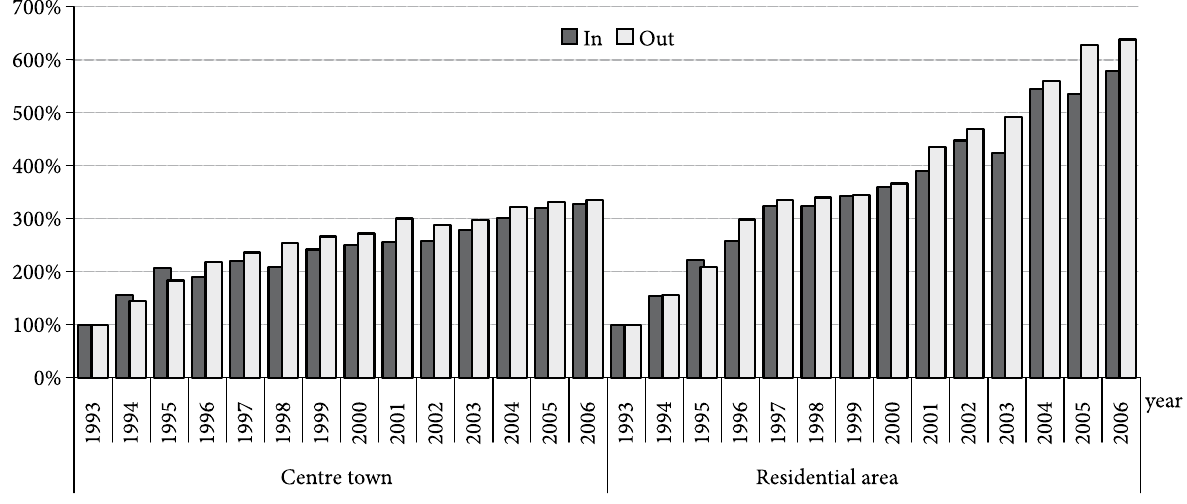
fig. 2. Change of traffic volume in Tartu compared to 1993 (evening rush